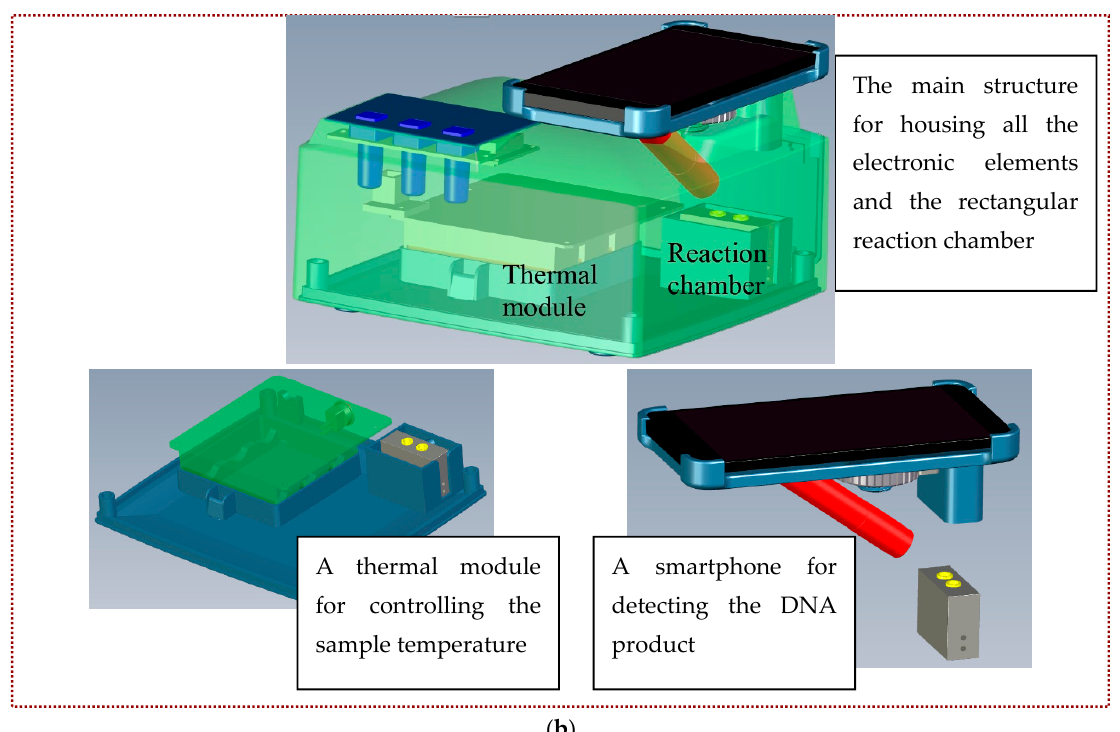
Figure 1. ( a ) The photograph and ( b ) schematic diagram of the portable analysis device. It consists of three individual parts, including the main structure, one thermal module and a smartphone. The length, width and height of the hand-held device are 173 mm, 156 mm and 112 mm, respectively.